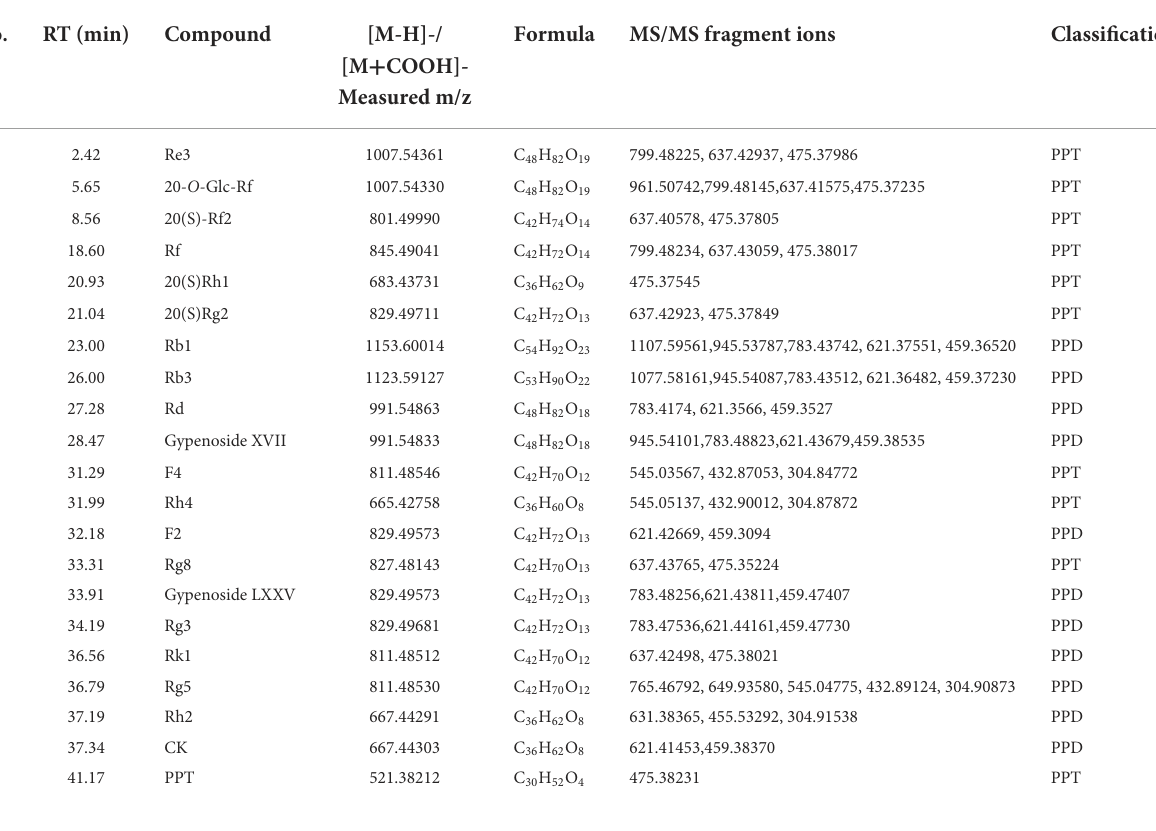
TABLE 1 Basic information on the 21 active components in